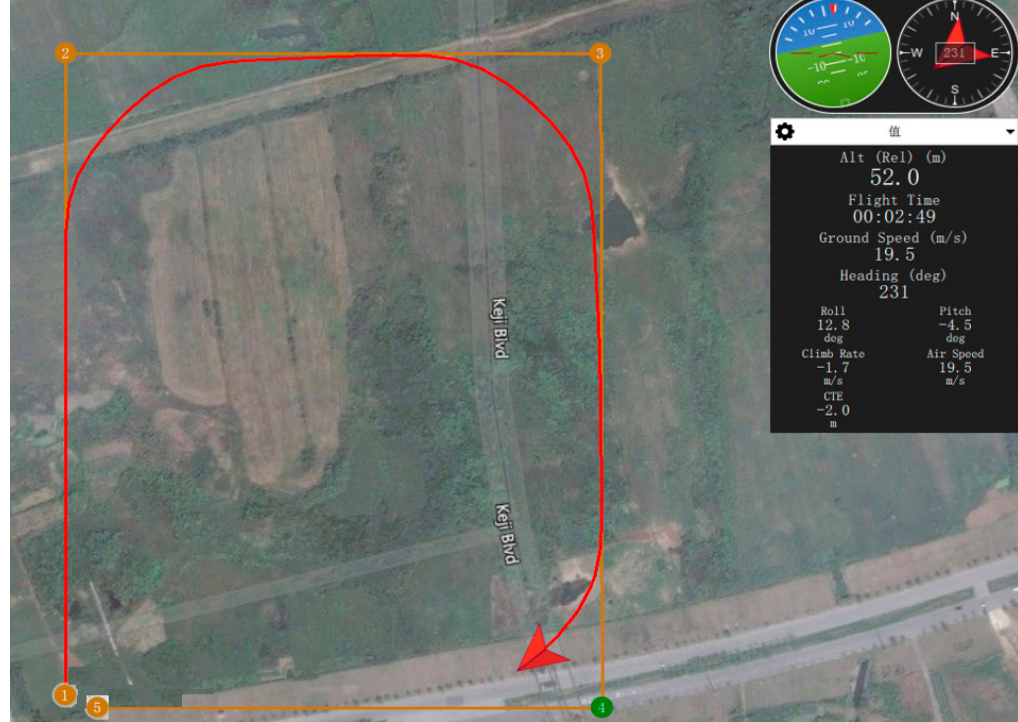
Figure 16. Semi-physical simulation of the lead aircraft tracking waypoints.